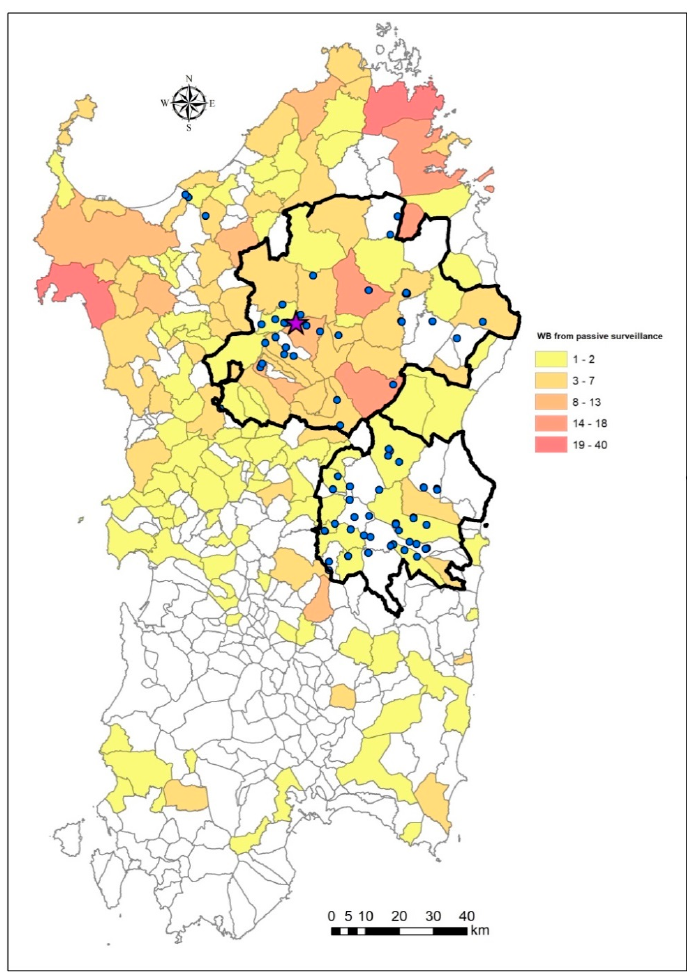
Figure 1. Epidemiological context of African swine fever in Sardinia from April 2019, and updated on October 2020. The violet star indicates the last two PCR-positive wild boar detected in April 2019, in the protected forest of Bultei (Sassari). The blue dots indicate the seropositive wild boar (WB). The proportion of animals tested via passive surveillance in each municipality is presented as a cloropletic map. The bold black lines define the limits of the two areas of Goceano–Baronia (the largest) and Barbagia–Ogliastra (the